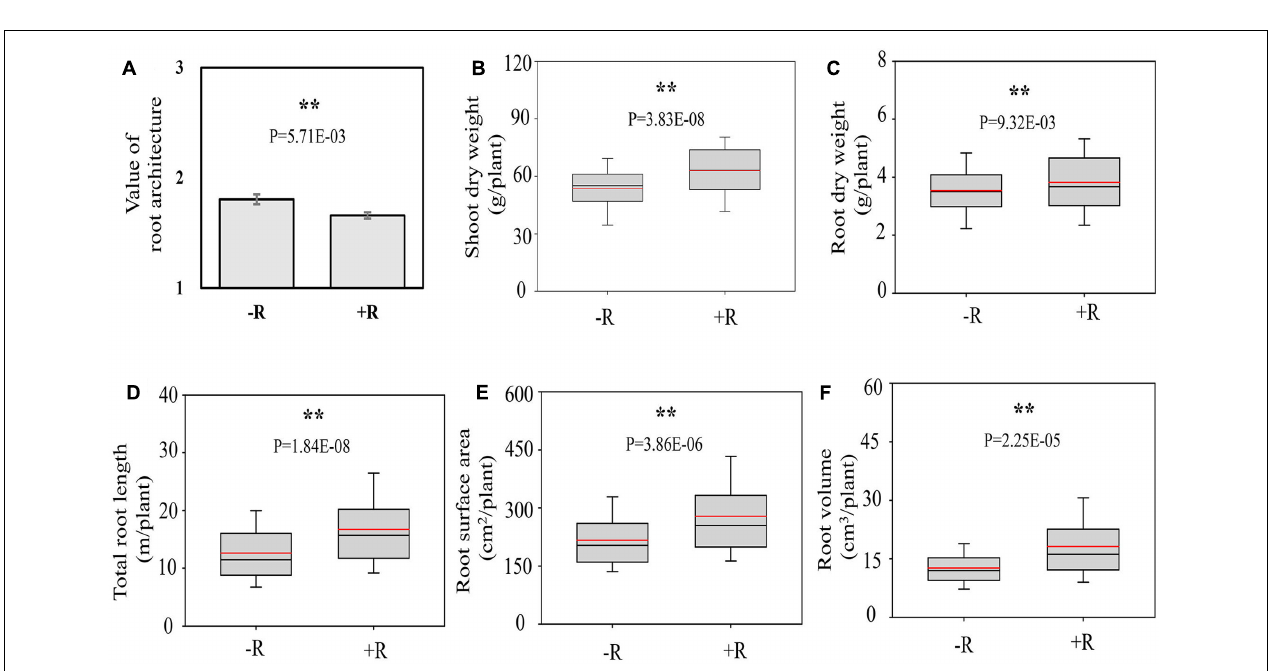
FIGURE 3 | Root architecture traits as affected by rhizobial inoculation in175 F 9 : 11 soybean recombinant inbred lines (RILs) under field conditions. (A) Value of RA; (B) shoot dry weight (SDW); (C) root dry weight (RDW); (D) total root length (TRL); (E) root surface area (RSA); (F) root volume (RV). Value of shallow, intermediate and deep RA was recorded as 1, 2, and 3 (see Materials and Method for details), respectively. “–R” and “+R” represent without and with rhizobial inoculation, respectively. The black and red lines, lower and upper edges, and bars up or low side the boxes represent median and mean values, 25th and 75th, 5th and 95th percentiles of all data, respectively. Asterisks indicate the significance of differences between –R and +R conditions through student t -test at 5% ( ∗ ) and 1% ( ∗∗ ) level, respectively.